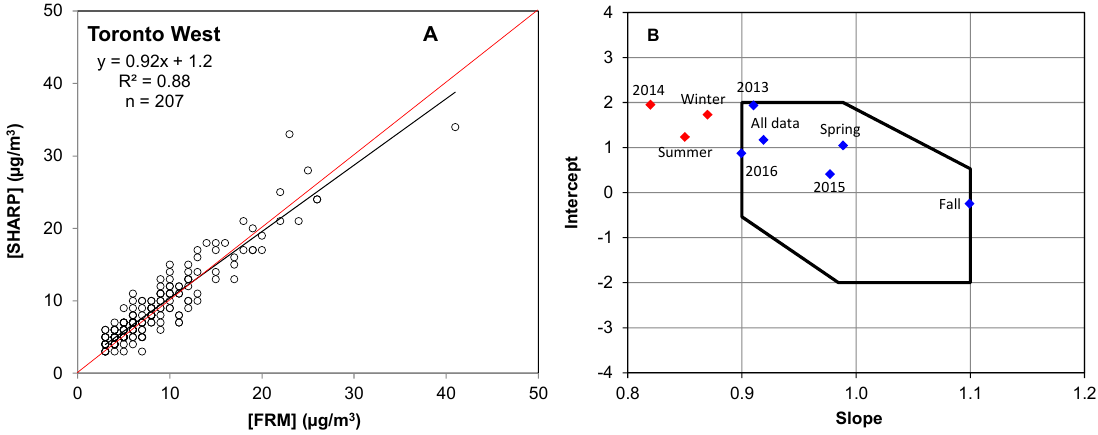
Figure 3. Comparison between the 24 h FEM SHARP 5030 and the FRM concentrations at the Toronto West station for all data included ( A ) and the acceptance limits of slope and intercept for PM 2.5 Class III FEM designated by the United States Environmental Protection Agency (U.S. EPA) in various scenarios ( B ). Table 3. Linear regression results of the FEM SHARP 5030 vs the FRM at the Toronto West station. Slope Intercept r Count Ratio (FEM/FRM) All data 0.92